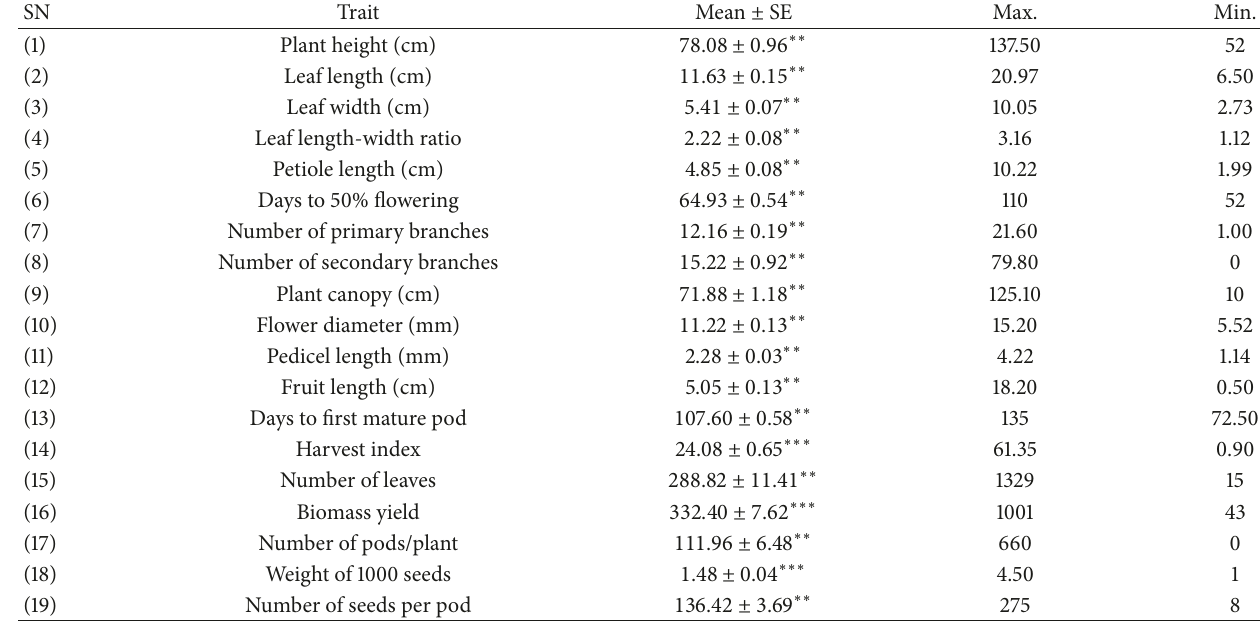
Table 4: The results of descriptive statistics for quantitative